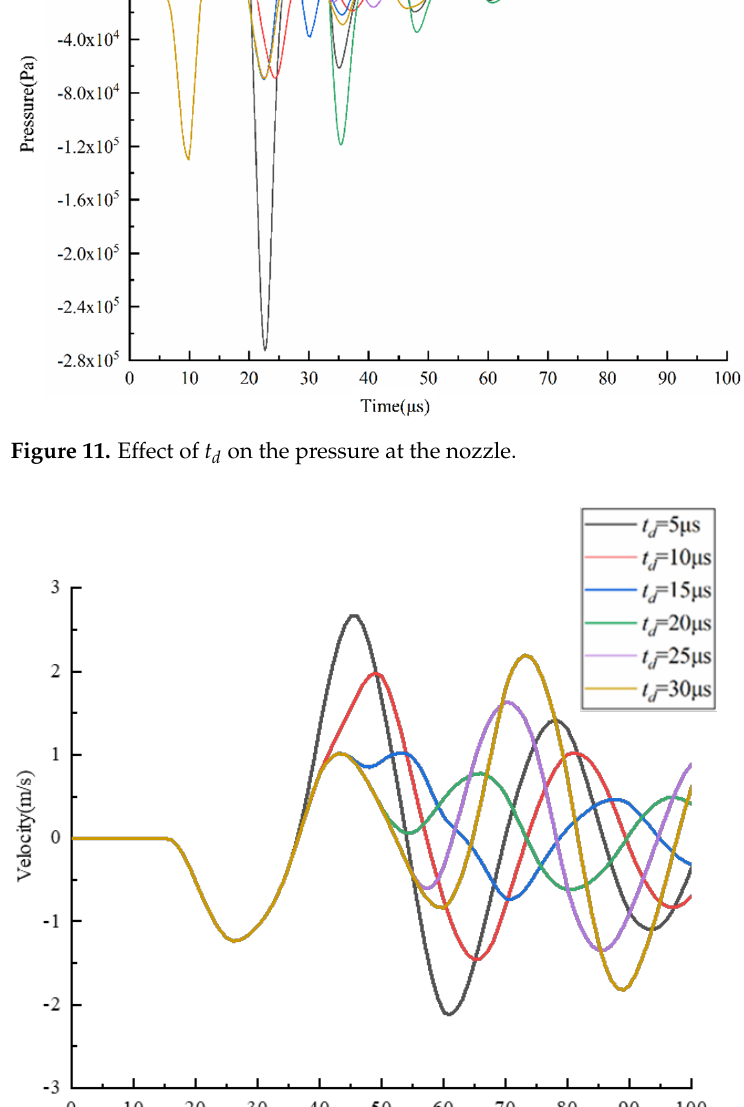
Figure 12. Effect of t d on the velocity at the nozzle.